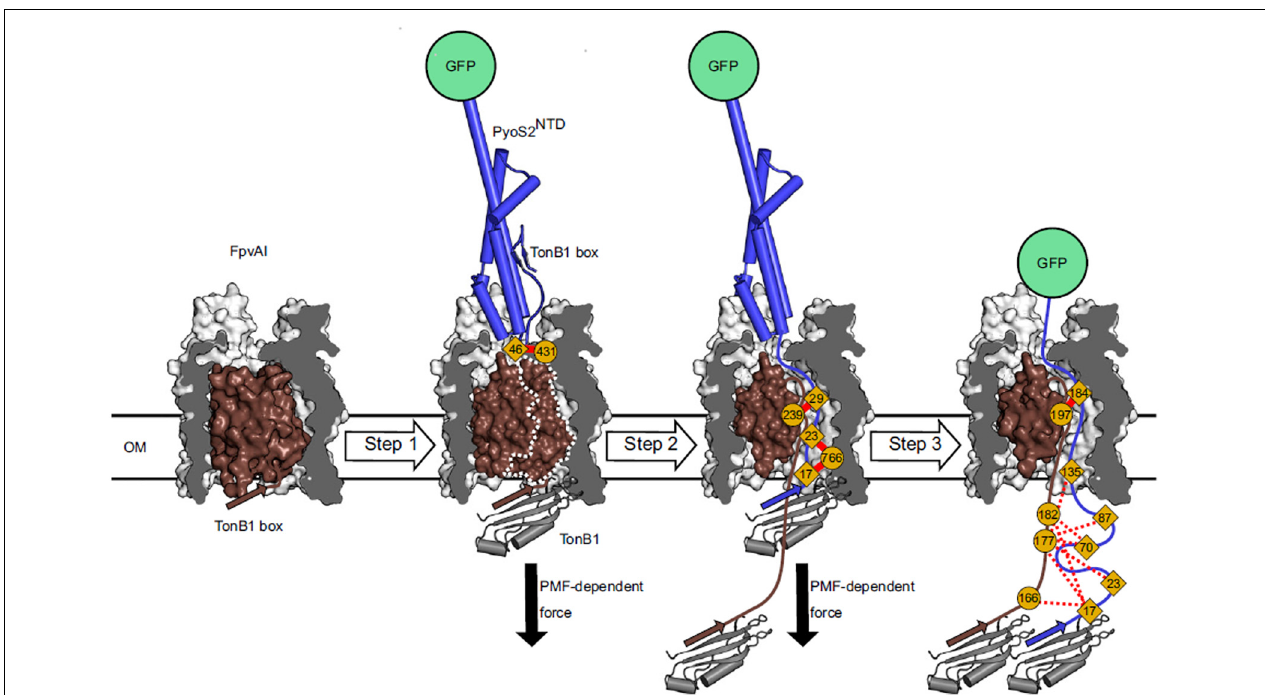
FIGURE 3 | In vivo cross-linking strategy developed by White et al. for dissecting the import pathway of pyocin S2 through the FpvAI receptor. Photoactivatable crosslinking data were used to establish a three-step model of translocation. In step 1, pyocin S2 binds to FpvAI and mimics its cognate ligand, ferro-pyoverdine. In step 2, a PMF-dependent mechanical force, applied via the ExbB–ExbD–TonB1 complex in the IM (not shown), drives unfolding of the labile half of the receptor plug domain and the N terminus of pyocin S2 enters the receptor lumen. In step 3, pyocin S2 binds to TonB1 and this interaction drives further passage of the pyocin through the receptor lumen. Complete translocation is blocked by the force-resistant GFP, which enables identification of translocation intermediates and mapping of interactions that govern pyocin S2 cell entry [image taken and used with permission from White et al. (2017), CC BY-NC-ND